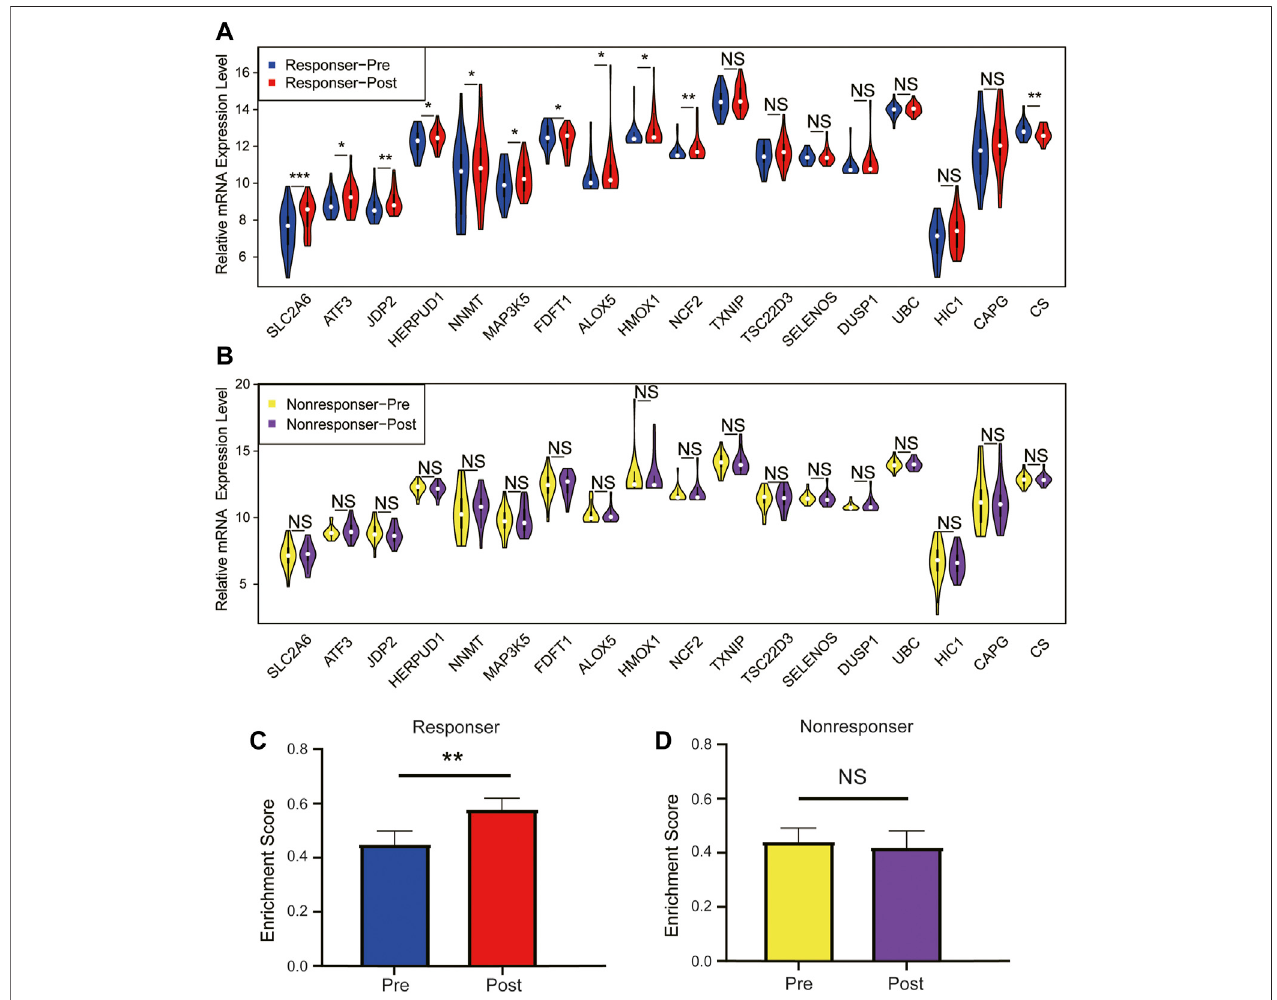
FIGURE 5 | Relative mRNA expression level of module – gene between patient pre- and post-nivolumab treatment. Differential expression of the individual module – gene in patients before and after anti-PD-1 treatment in the response group (A) and the nonresponse group (B) . The mRNA expression was calculated in the formoflog2(FPKM+1)andpresentedasviolinplots.Thewholemodulegeneexpression(enrichmentscore)offerroptosisinpatientsbeforeandafteranti-PD-1treatment in the response group (C) and nonresponse group (D) . Data were expressed as the mean ± standard error and analyzed using Student ’ s t test (* p < 0.05; ** p < 0.01; and *** p < 0.001).